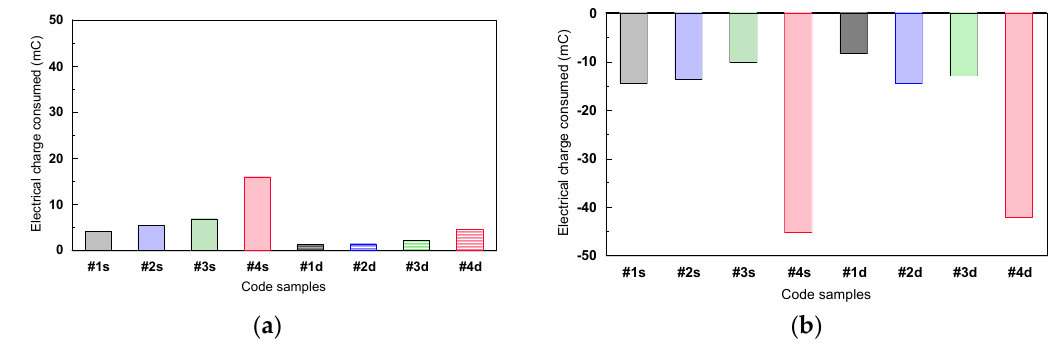
Figure 24. The total electrical charge consumed for the fatigue corrosion tests in 9 g/L NaCl during ( a ) the passivation and ( b ) the depassivation steps (s: static and d: dynamic mechanical cycles).